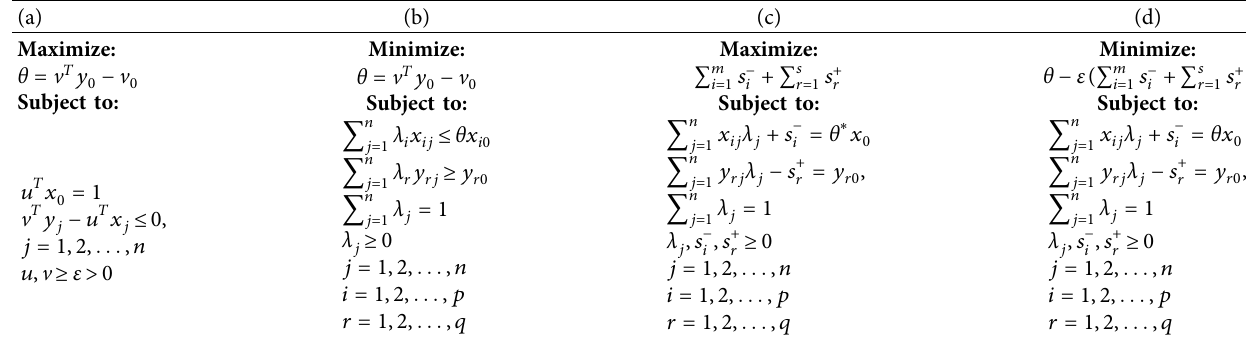
Table 3: Input-oriented BCC